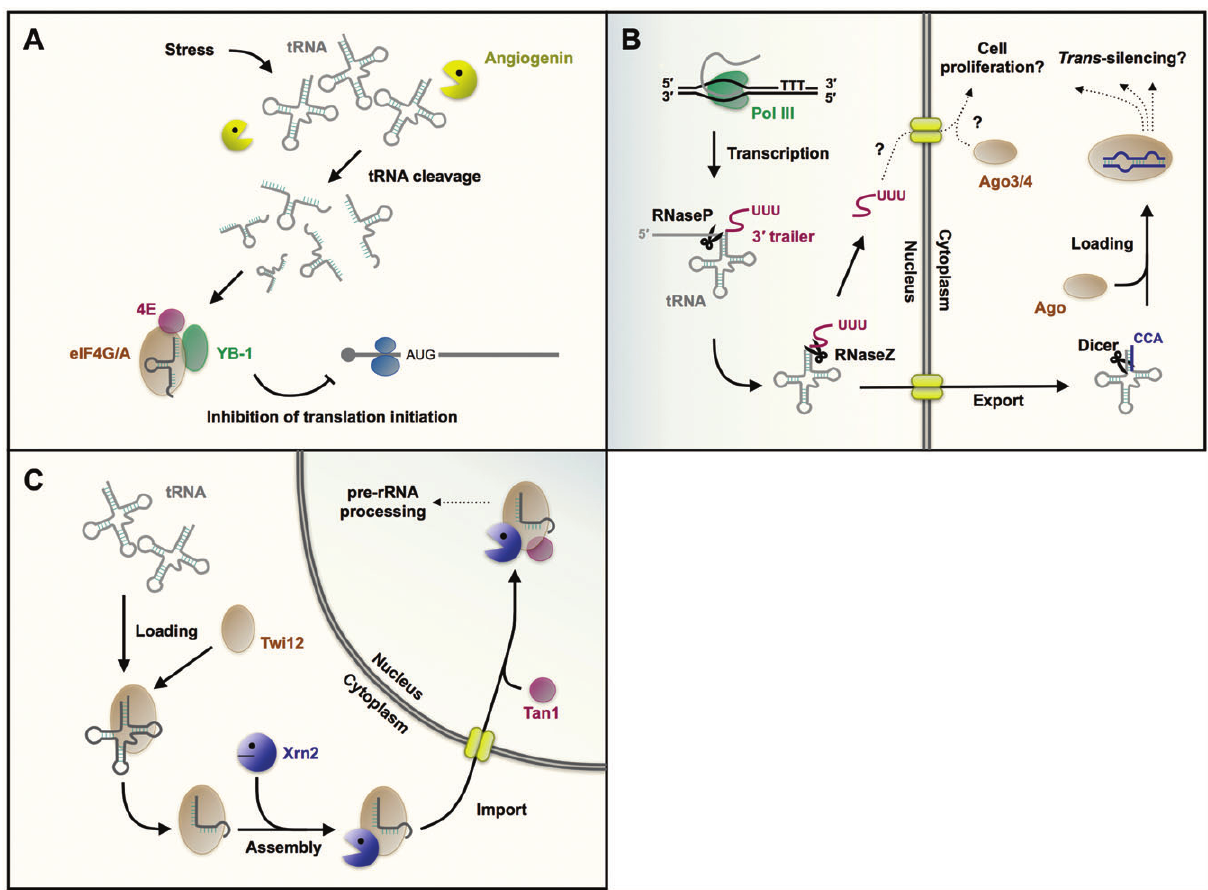
Figure 4 Three examples of tRNA-derived small RNA